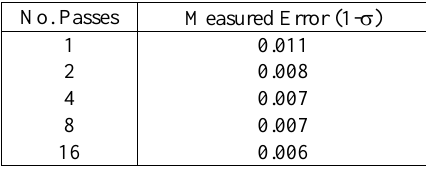
Table 4. Measured standard deviation errors based on number of